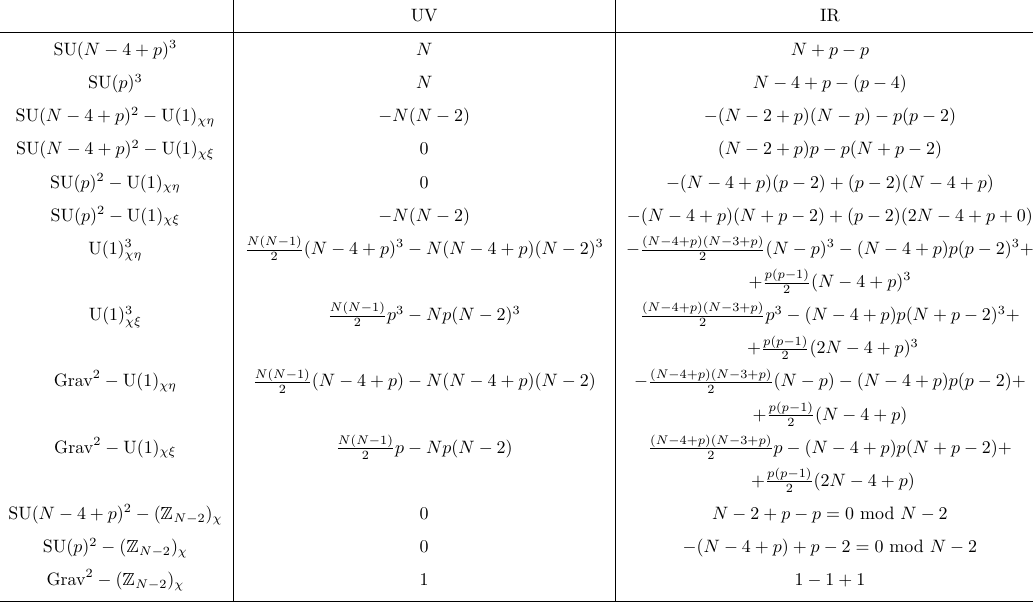
Table 11 . Anomaly matching checks for the IR chiral symmetric phase of the GG